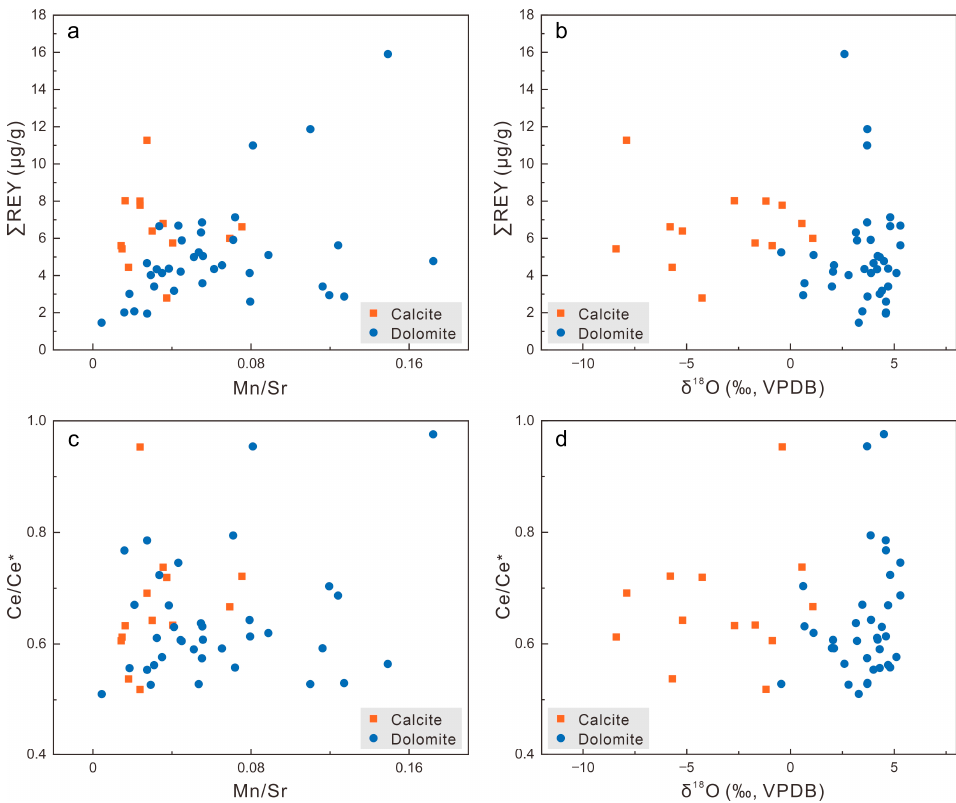
Figure 6. ( a ) ∑ REY vs. Mn/Sr, ( b ) ∑ REY vs. δ 18 O, ( c ) Ce/Ce* vs. Mn/Sr, ( d ) Ce/Ce* vs. δ 18 O in the XK-1 core carbonates. The δ 18 O data are from [44–46]. For both calcite and dolomite samples, neither ∑ REY nor Ce/Ce * show any correlations with Mn/Sr or δ 18 O.